Question: Write a single sentence explaining what this figure depicts.
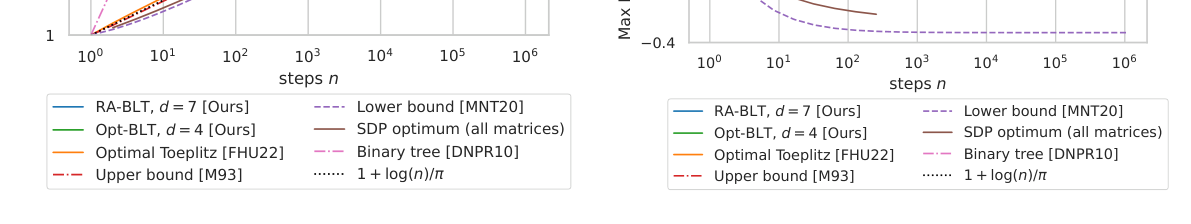
Answer: Comparison of known upper and lower bounds for factorizations A = BC of the all-ones lower triangular matrix Ai,j = I[i ≥j]. Note that this includes non-Toeplitz factorizations. This illustrates that there is a small gap between lower triangular Toeplitz factorizations and general fac- torizations; furthermore this gap is asymptotically constant. Left: Vertical axis is MaxErr(B, C). Right: Vertical axis is MaxErr(B, C) −OptLTToe(n).